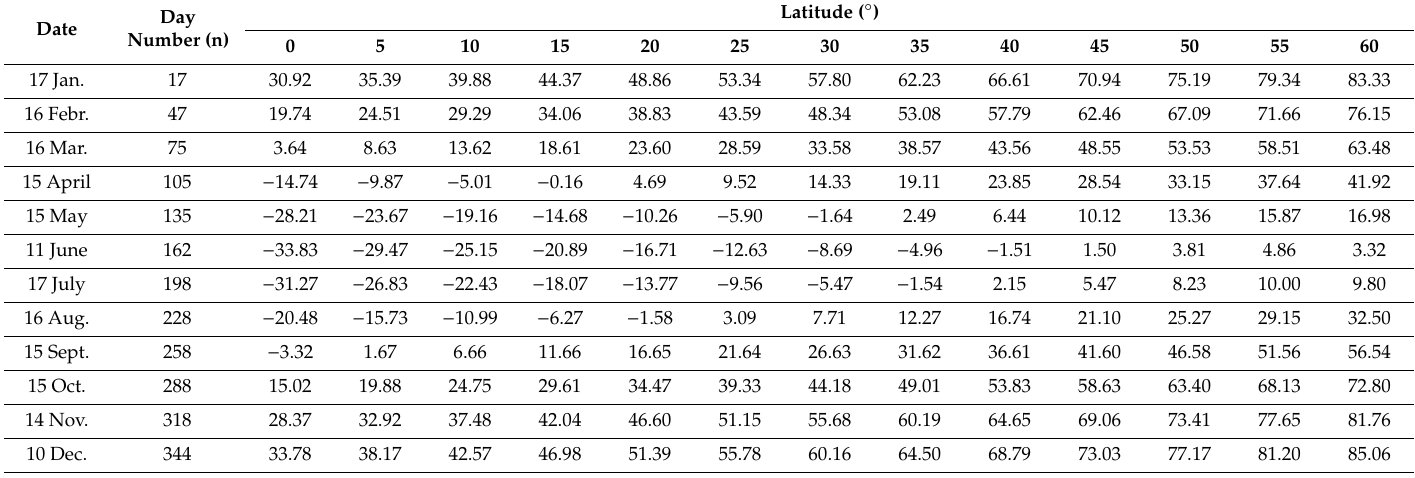
Table 2. The daily optimum tilt angle β opt,d for recommended average days of months for di ff erent latitude angles.